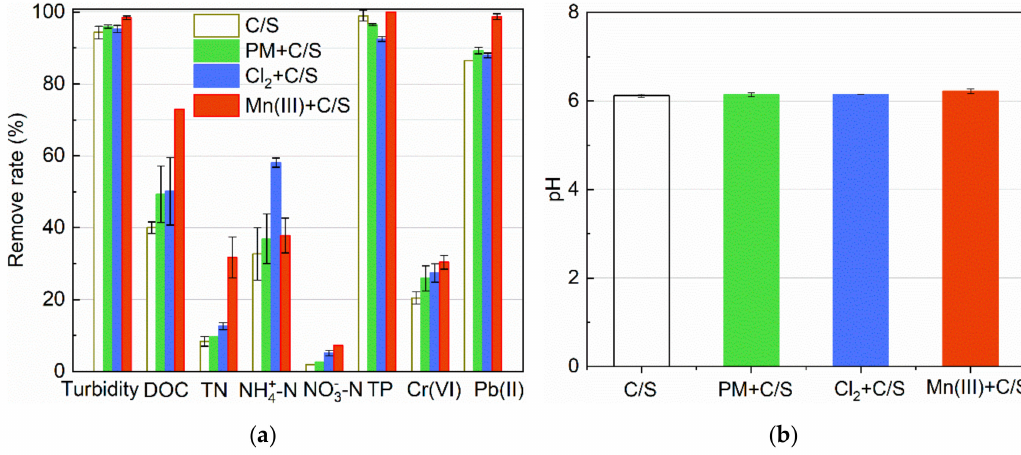
Figure 2. ( a ) Removal e ffi ciency of conventional pollutants by C / S and C / S enhanced with Mn(III) pre-oxidation, KMnO 4 pre-oxidation, and chlorine pre-oxidation. ( b ) The final pH value of simulated water after treatment by di ff erent